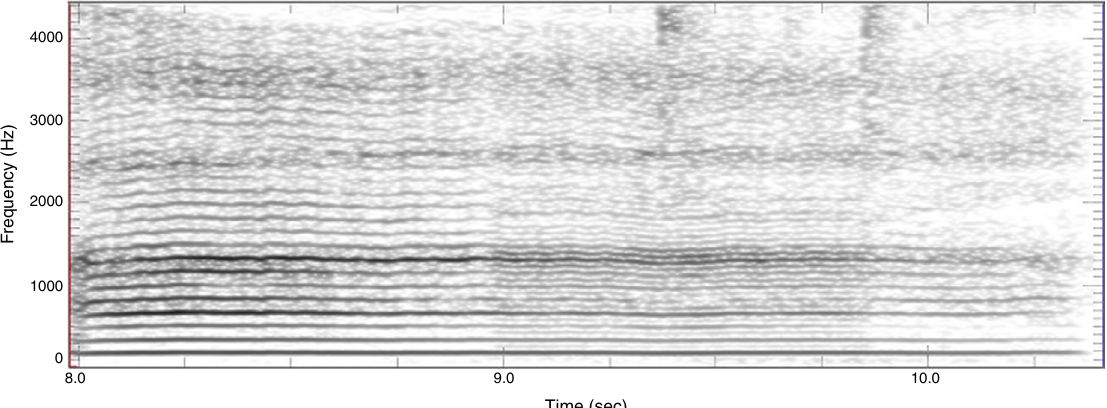
The spectrographic examination executed after surgery points out the presence of noise between the harmonics and of